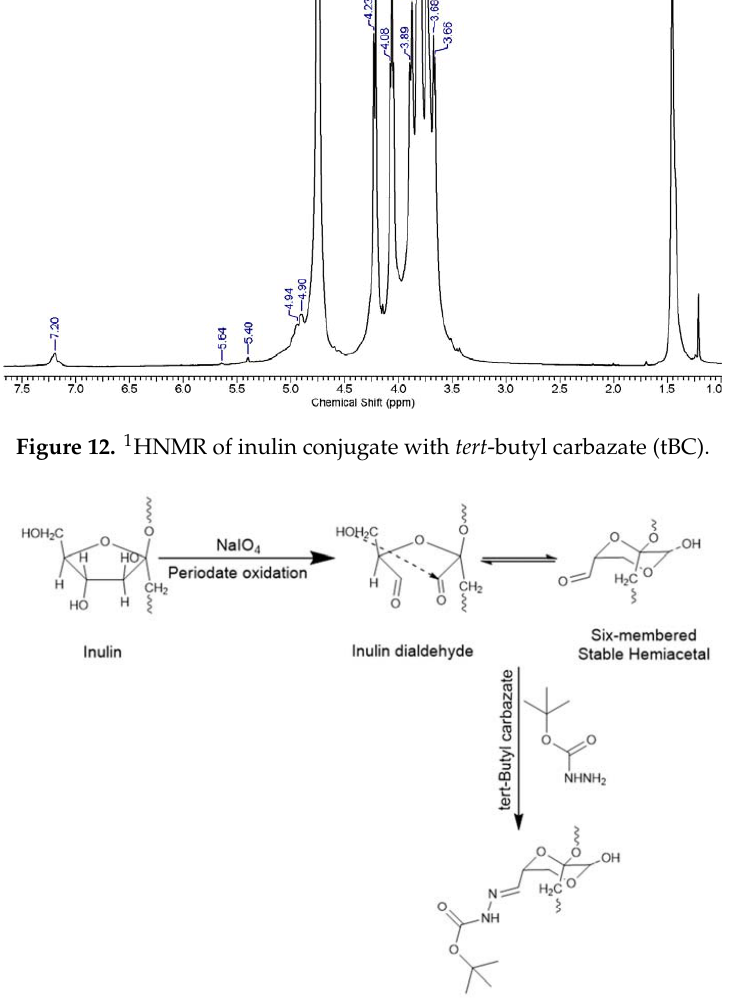
Scheme 2. Showing the reaction between oxidized inulin and tBC.